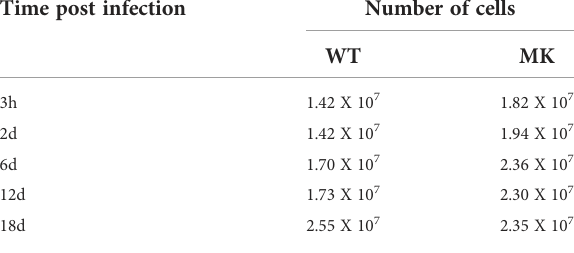
TABLE 5 Number of 3T3-L1 cells at different time-points. HAdV-36- infected vs MK-infected at 12 dpc in MDI. Time post